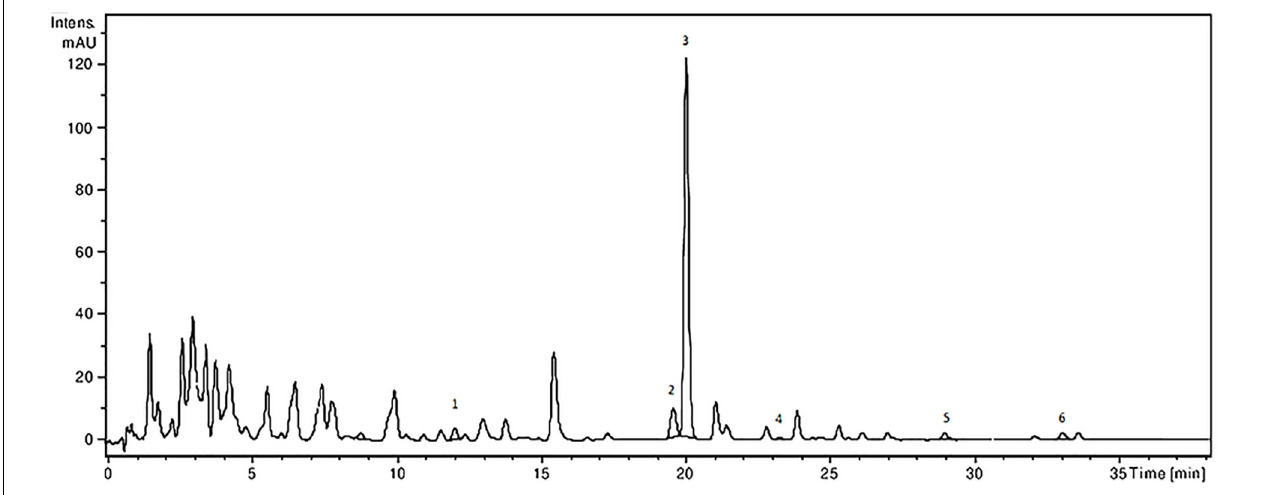
FIGURE 1 | HPLC-UV-MS chromatogram of polyphenolic compounds from A. laxmannii ethanol extract. The identified compounds: ferulic acid (1), isoquercitrin (2), rutin (3), quercitrin (4), luteolin (5), and apigenin (6).